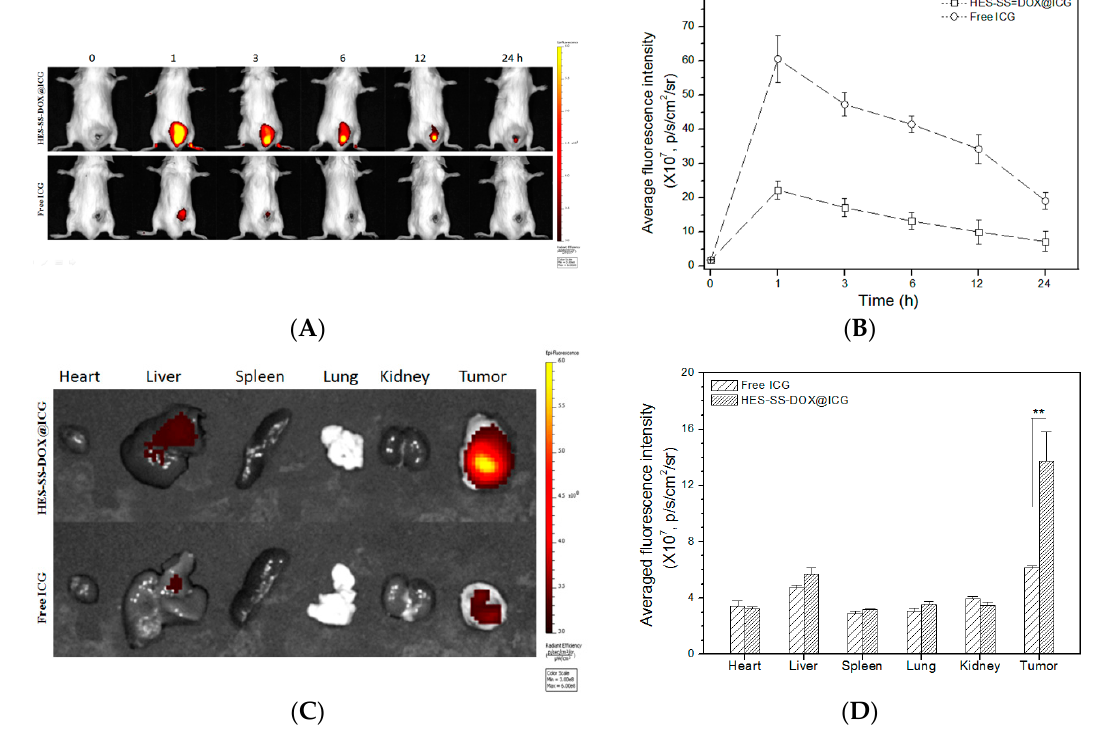
Figure 5. Representative fluorescence images and average fluorescence intensity. Real-time fluorescence images ( A ) of H22-tumor bearing BALB/c mice and matched fluorescence intensity ( B ) detected at different time points. ( C ) Ex vivo fluorescence images of major organs and tumors excised from two groups of mice and matched average fluorescence intensity ( D ) (harvesting time of organs and tumors in H22-tumor bearing mice, at 1 hour after injection of free ICG or HES-SS-DOX@ICG NPs. ** p < 0.01. n = 4).